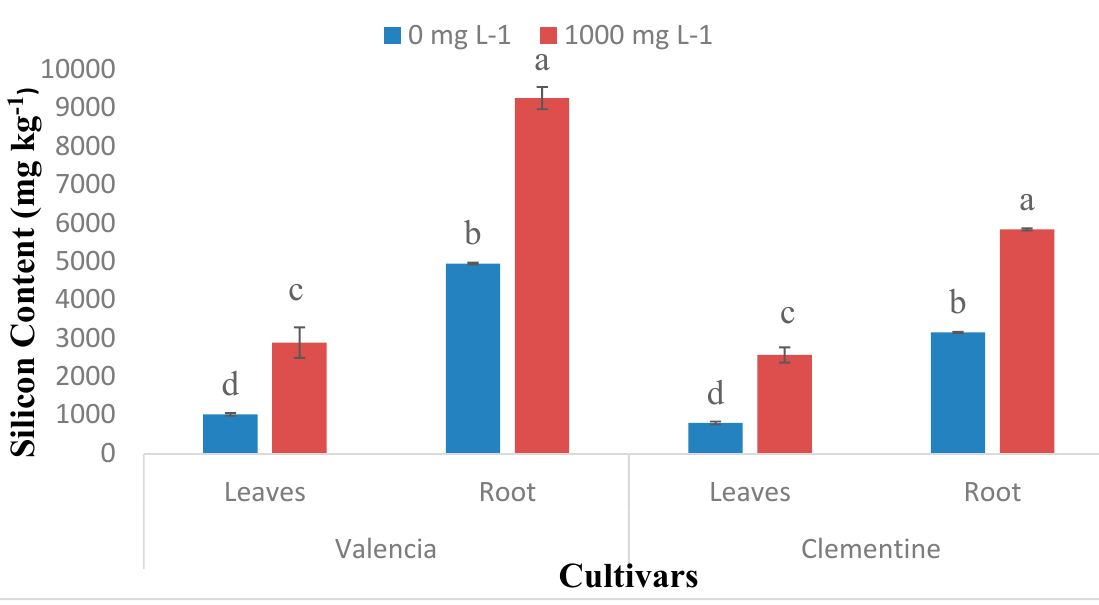
Figure 2. Si accumulation in mature leaves and roots of two citrus species. Bars sharing a letter are not significantly different. Data are means ± standard errors.